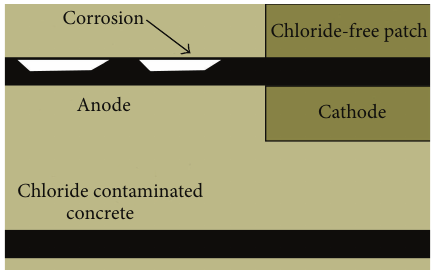
Figure 2: Patch-accelerated corrosion in concrete.